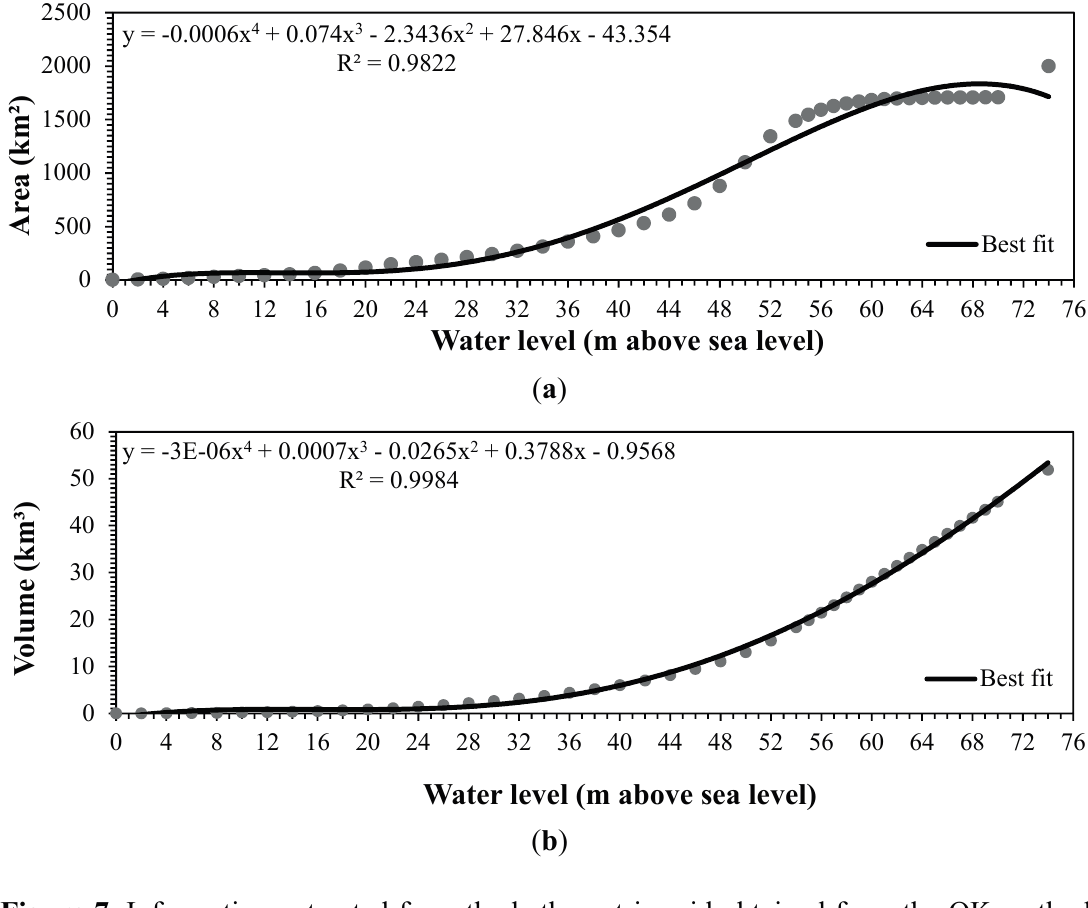
Figure 7. Information extracted from the bathymetric grid obtained from the OK method: ( a ) Level-area diagram; ( b ) Level-volume